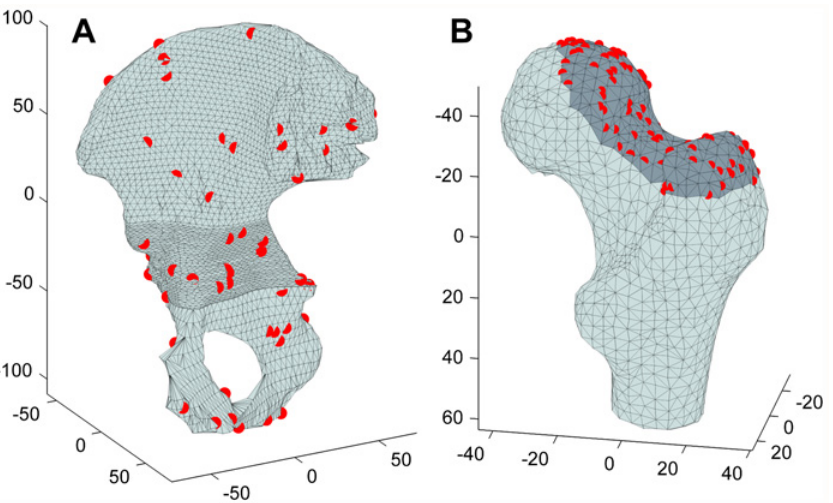
Fig 1. Human hip- and femur-bone meshes used in the registration studies. The red points represent a typical randomly generated source shape as sampled from the mesh surface. (A): The hip mesh is used in registration Experiments 2 – 5. (B): The femur mesh is used for the sub-shape registration study of Experiment 6, where points for the source shape are sampled from the shaded region of the